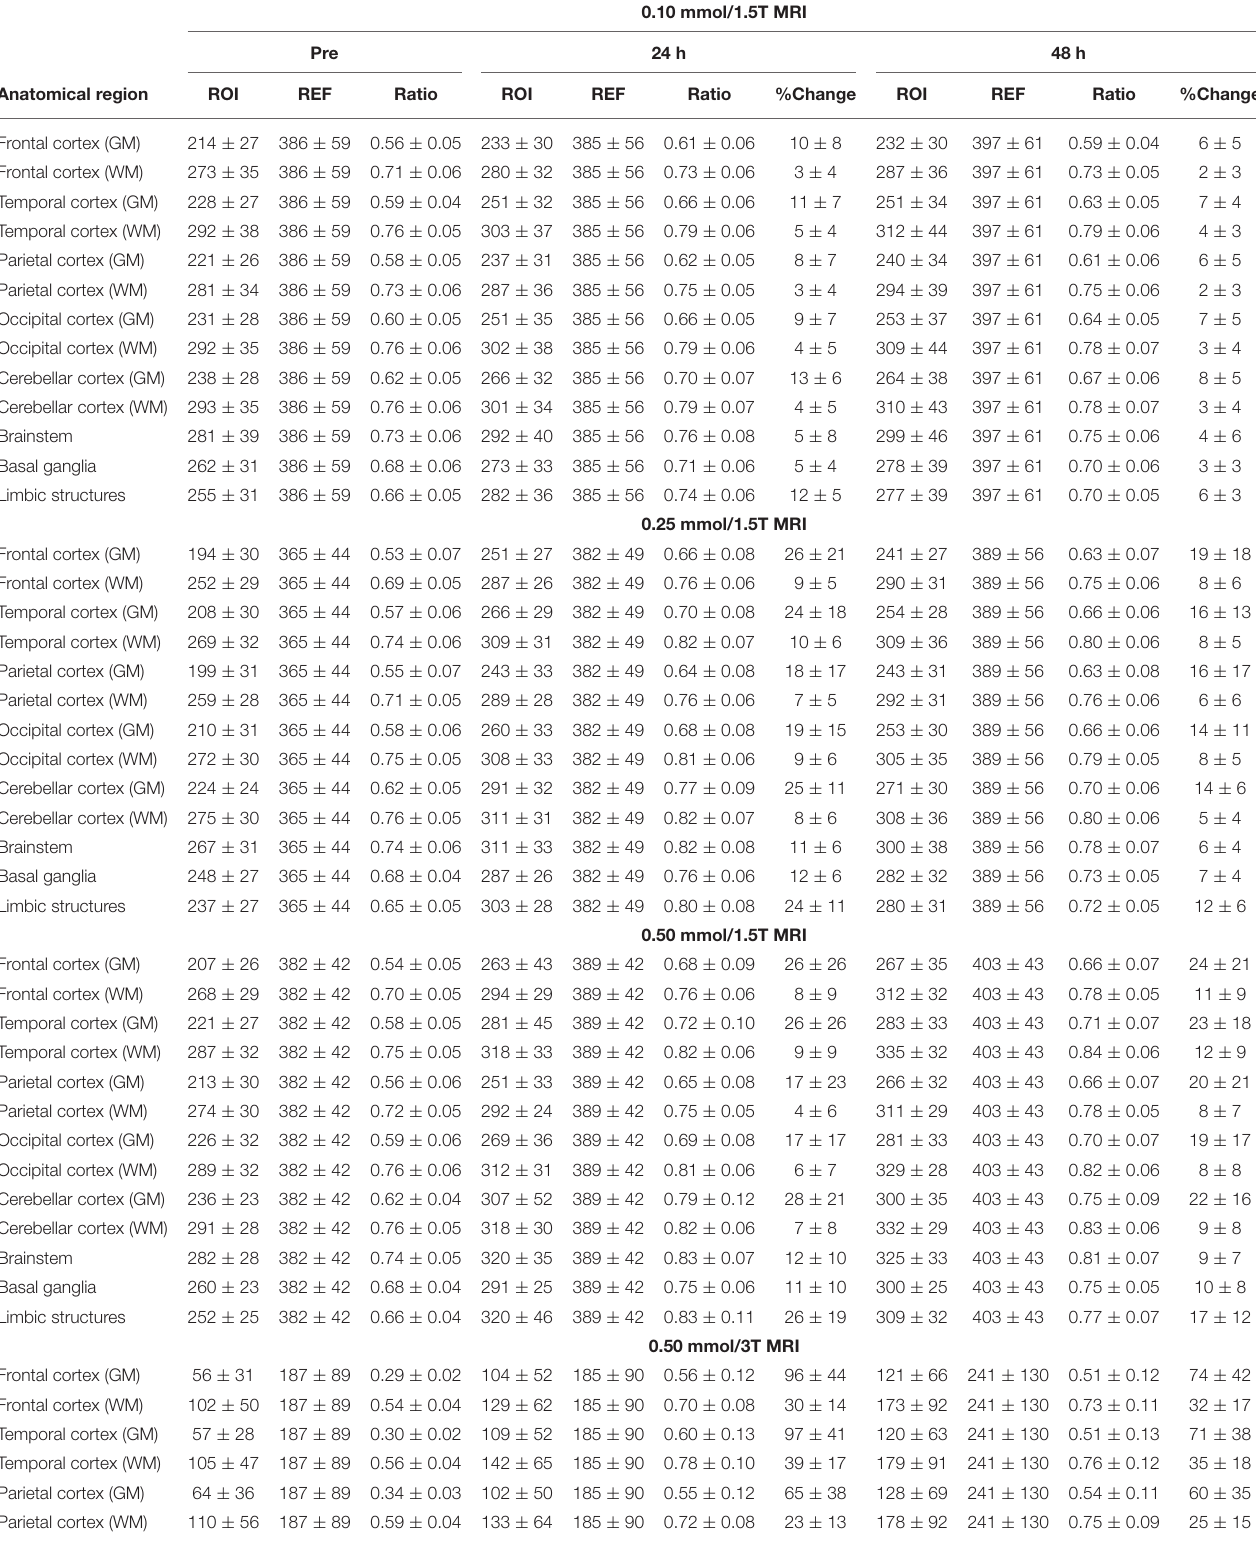
TABLE 4 | Dose-dependent change T1 signal units and normalized T1 within different brain regions after